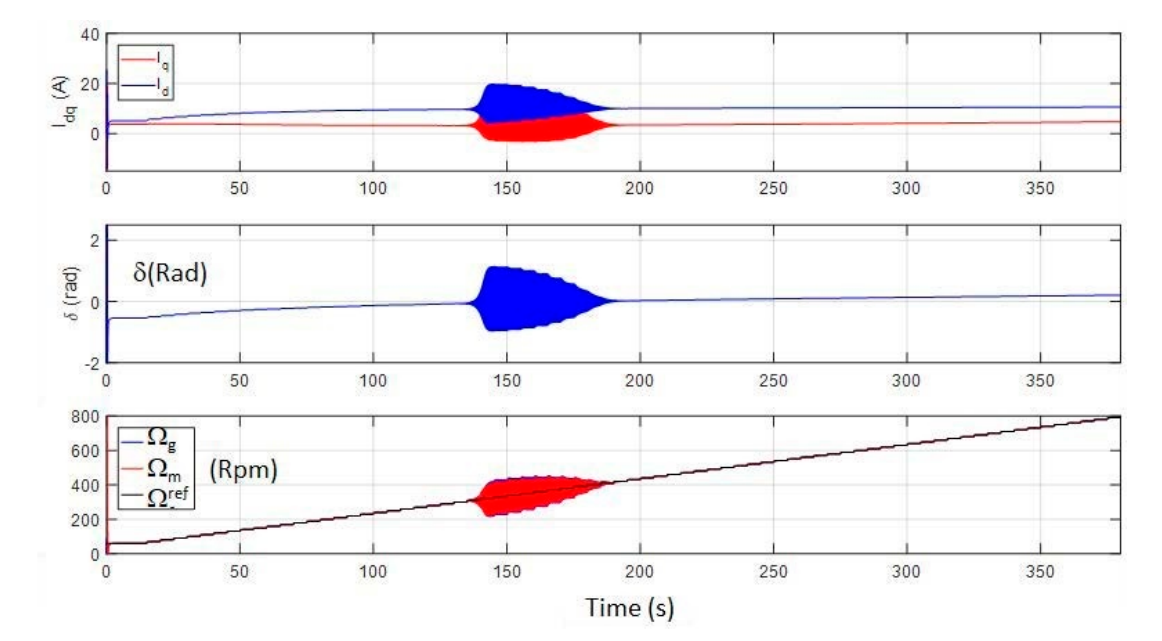
Figure 14. Small-signal model-based root locus analysis for coupled parametric modifications with a bandwidth of 1 Hz for the generator speed control and with coupled modifications of electric and mechanical parameters.